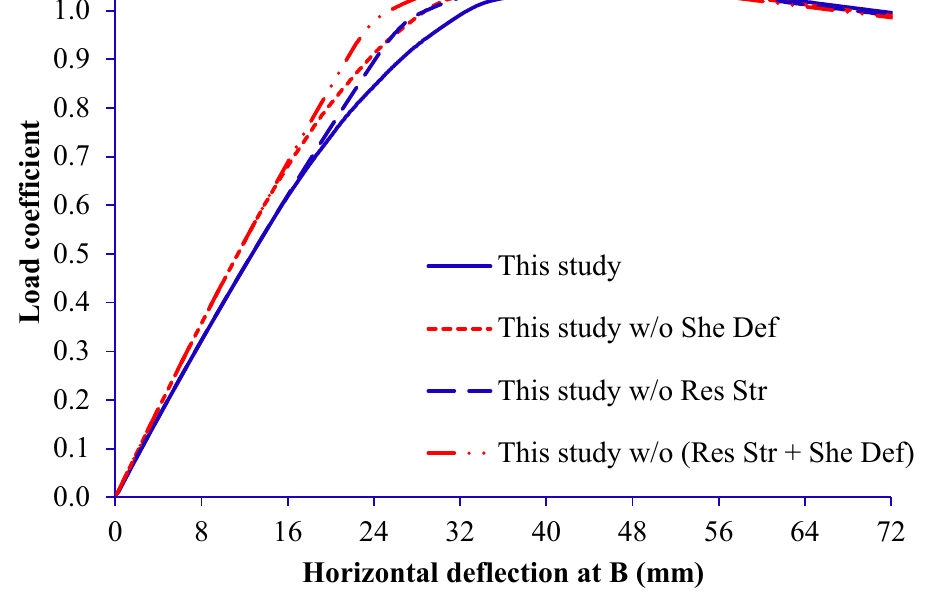
Fig. 29 Load–deflection relationship at B of nine-story